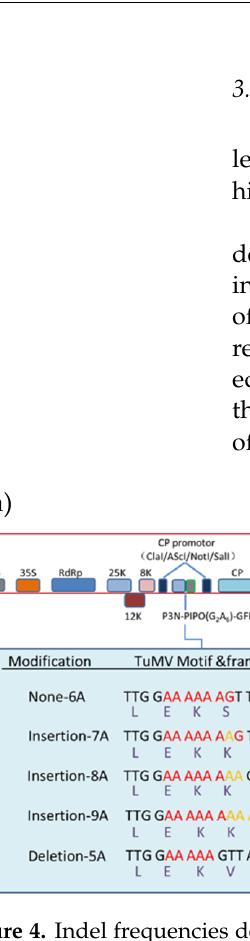
Figure 4. Indel frequencies derived from deep sequencing at the G 2 A 6 site of P3N-PIPO of TuMV and WYMV fused to GFP and expressed from a PVX vector in N. benthamiana . The P3N-PIPO-GFP constructs of TuMV ( a ) and WYMV ( b ) are depicted schematically. Details of the nucleotide sequences and resulting amino acid sequences of the translation products, as well as the RNA slippage frequencies detected for each modification are shown. Color codes in the pie charts refer to insertions (7A, 8A, 9A) or deletion (5A) compared to the wild type sequence (6A) of P3N-PIPO. The slippage frequency associated with a single adenosine insertion (7A) is highlighted in the red rectangular boxes.